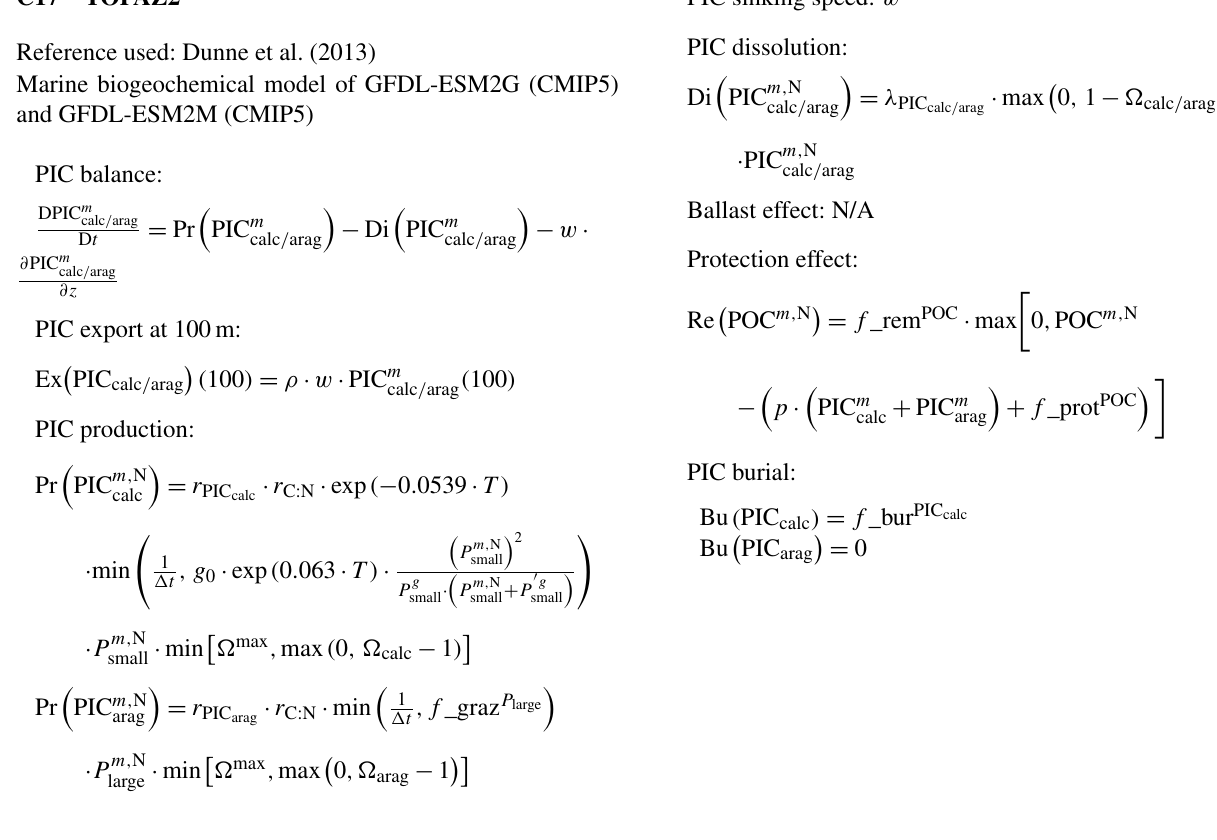
Table C17. TOPAZ2